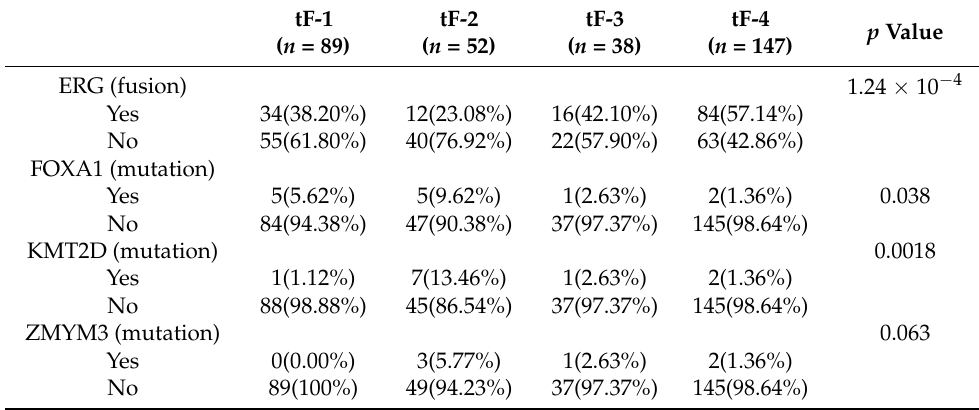
Table 2. Key driver events in four tRF subtypes of